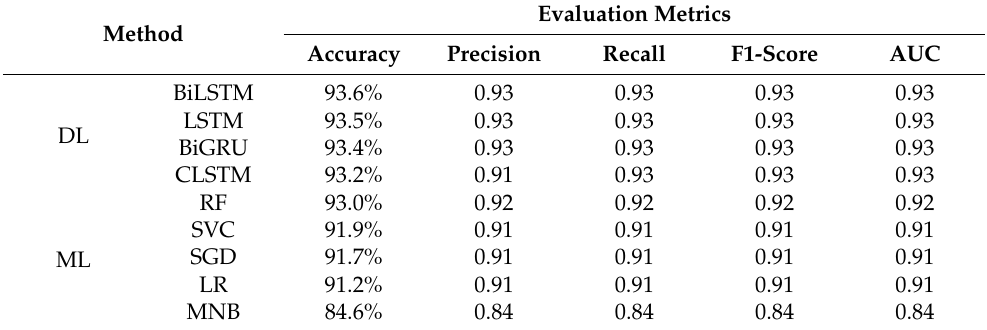
Table 2. Performance Table for